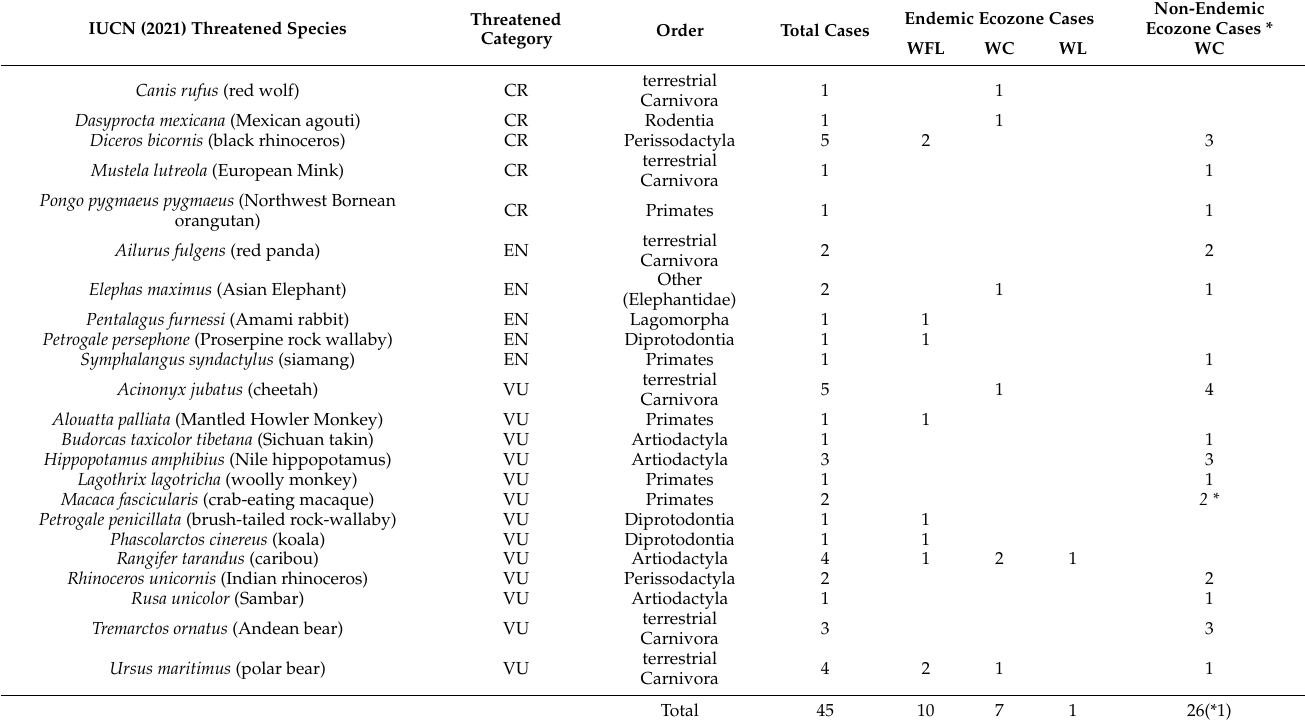
Table 4. International Union for Conservation of Nature’s (IUCN) Red List of threatened wild mammal species reported as having dermatitis. The 23 species categorized as ‘Critically Endangered’ (CR), ‘Endangered’ (EN), and ‘Vulnerable’ (VU) are shown, including their order and total number of cases. The number of dermatitis cases within endemic ecozones are shown for each species and the number of cases within non-endemic ecozones. Both ecozone categories are separated into the following captivity statuses of: Wild Captive (WC), Wild Free-living (WFL) and Wild Laboratory (WL). * WFL has one reported case within a non-endemic ecozone (*), and WL has no reported cases across non-endemic ecozones, so the columns have been removed to simplify the